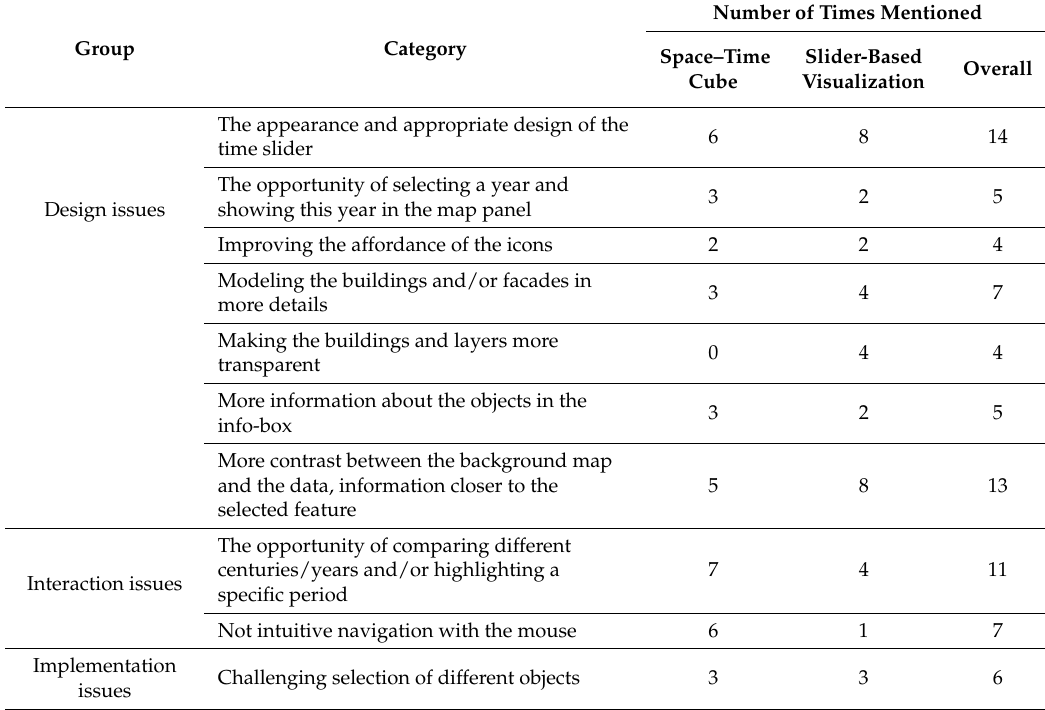
Table 2. Categorized issues mentioned by the test participants divided into different